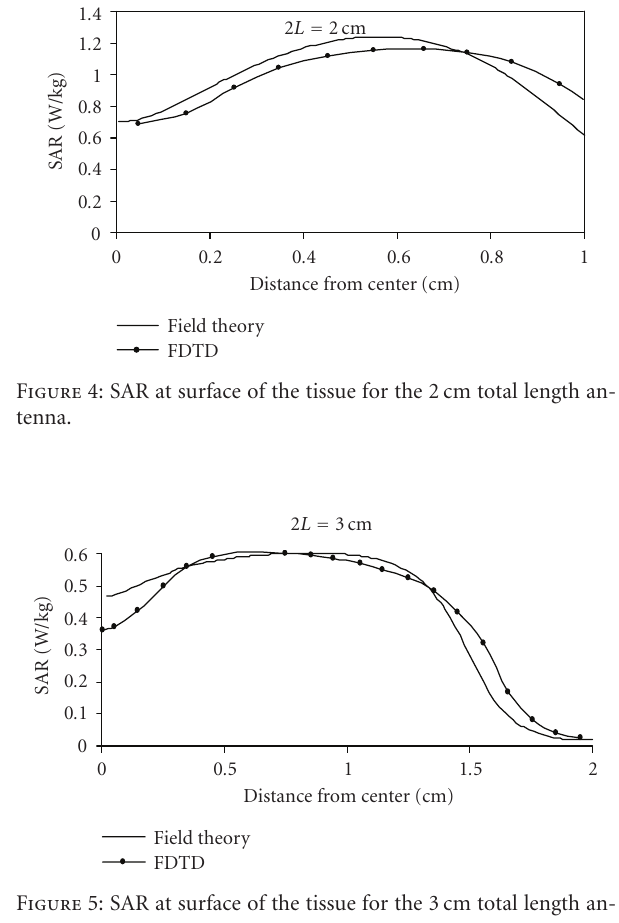
Figure 7: Steady-state temperature increases produced at the region of maximum SAR near the three